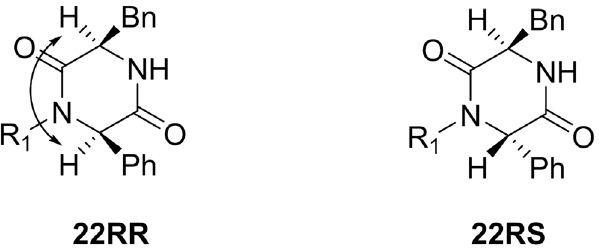
Fig 10. Stereochemical assignment of non-spiro-DKPs. NOE correlations are shown by a double headed arrow.